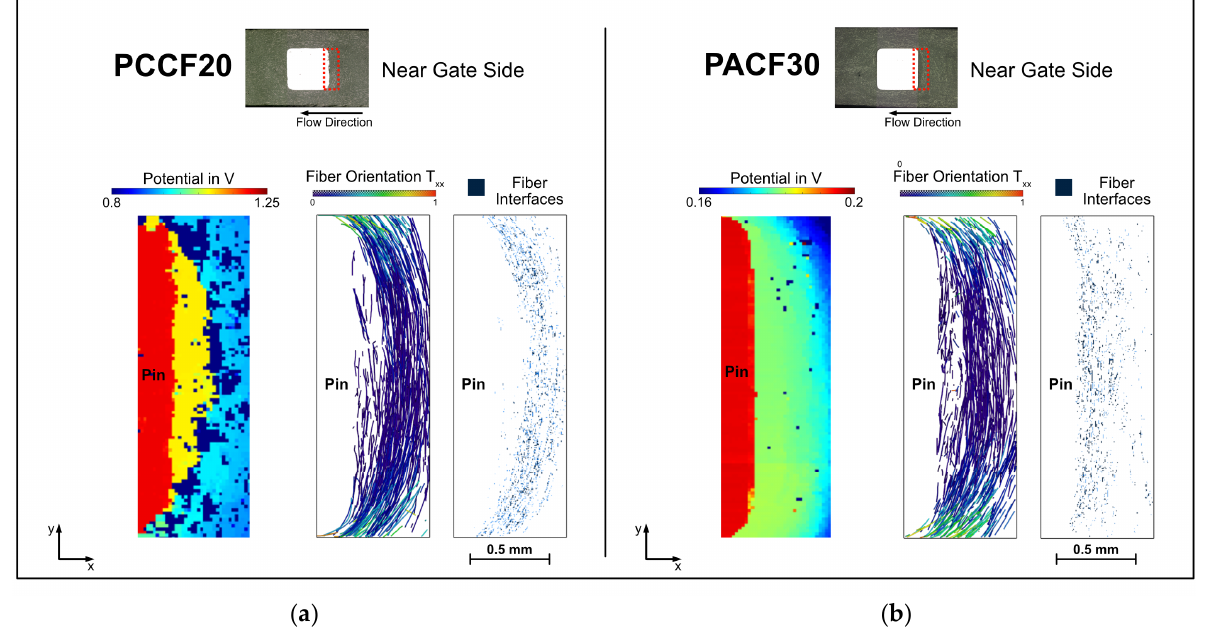
Figure 18. Comparison of the measured potential fields and the fiber orientation at the near gate sides of the specimen PC CF20_4 mm ( a ) and PA CF30_5 mm ( b ).